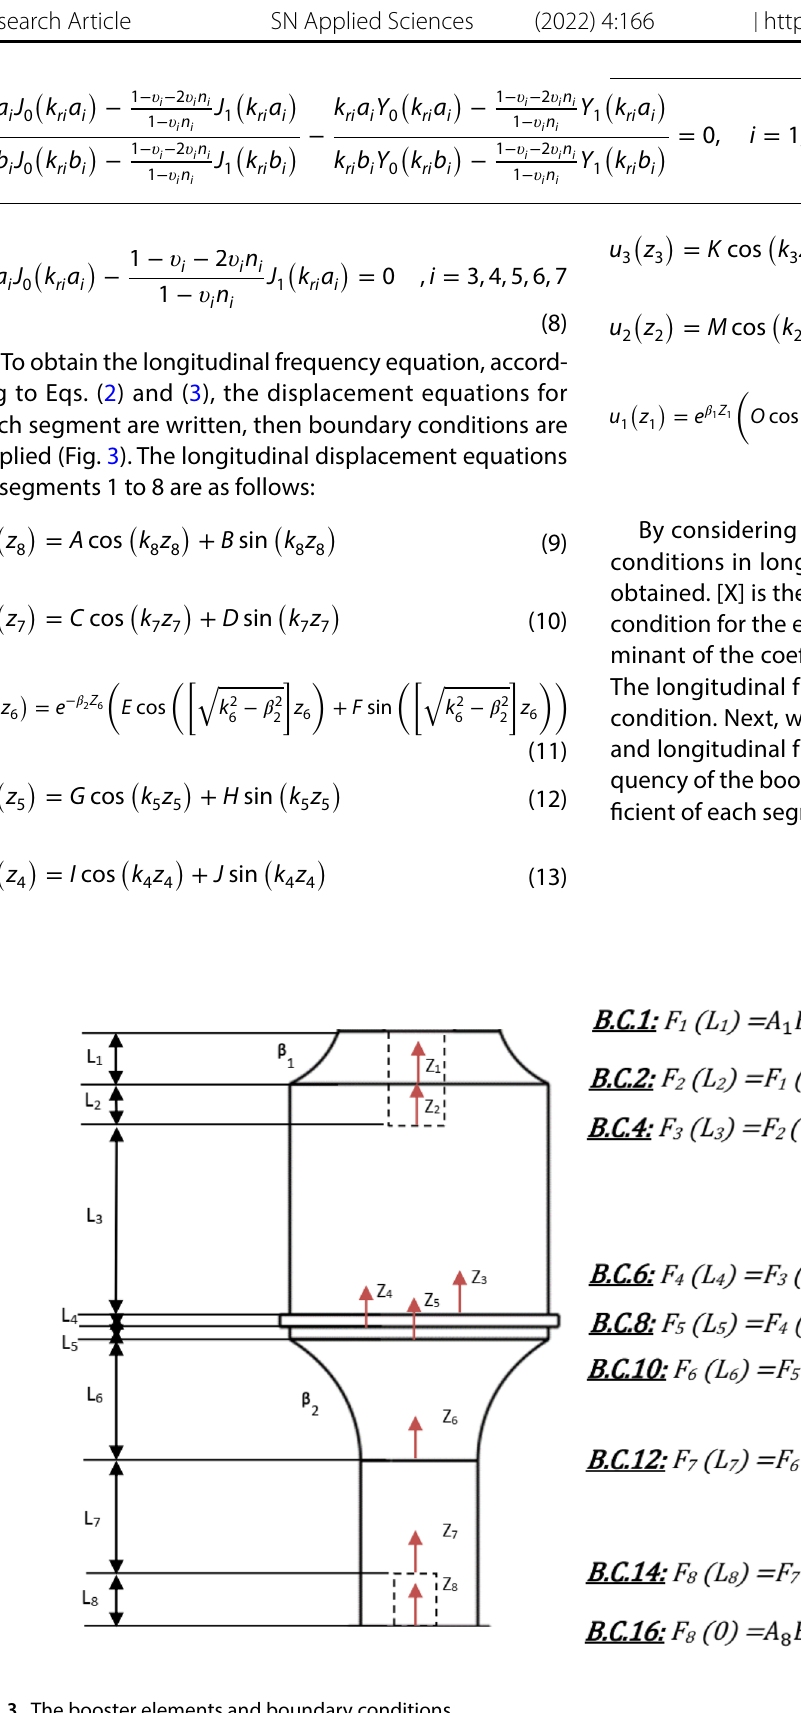
Fig. 3 The booster elements and boundary